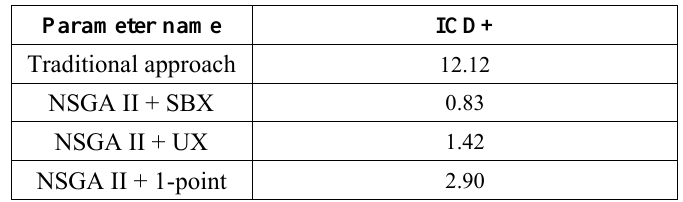
Table 2. Benchmarking